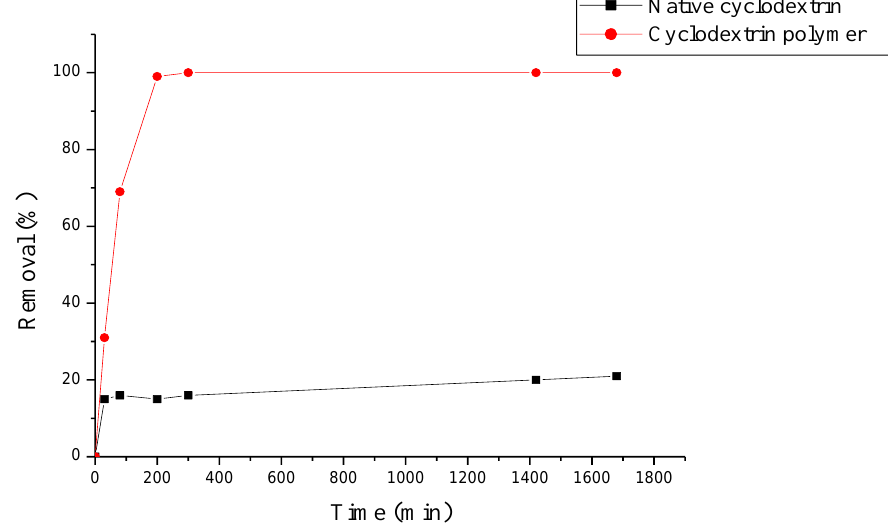
Figure 5. Comparison study of methyl purple removal with native β -cyclodextrin and β -cyclodextrin polymer, T = 30 °C.